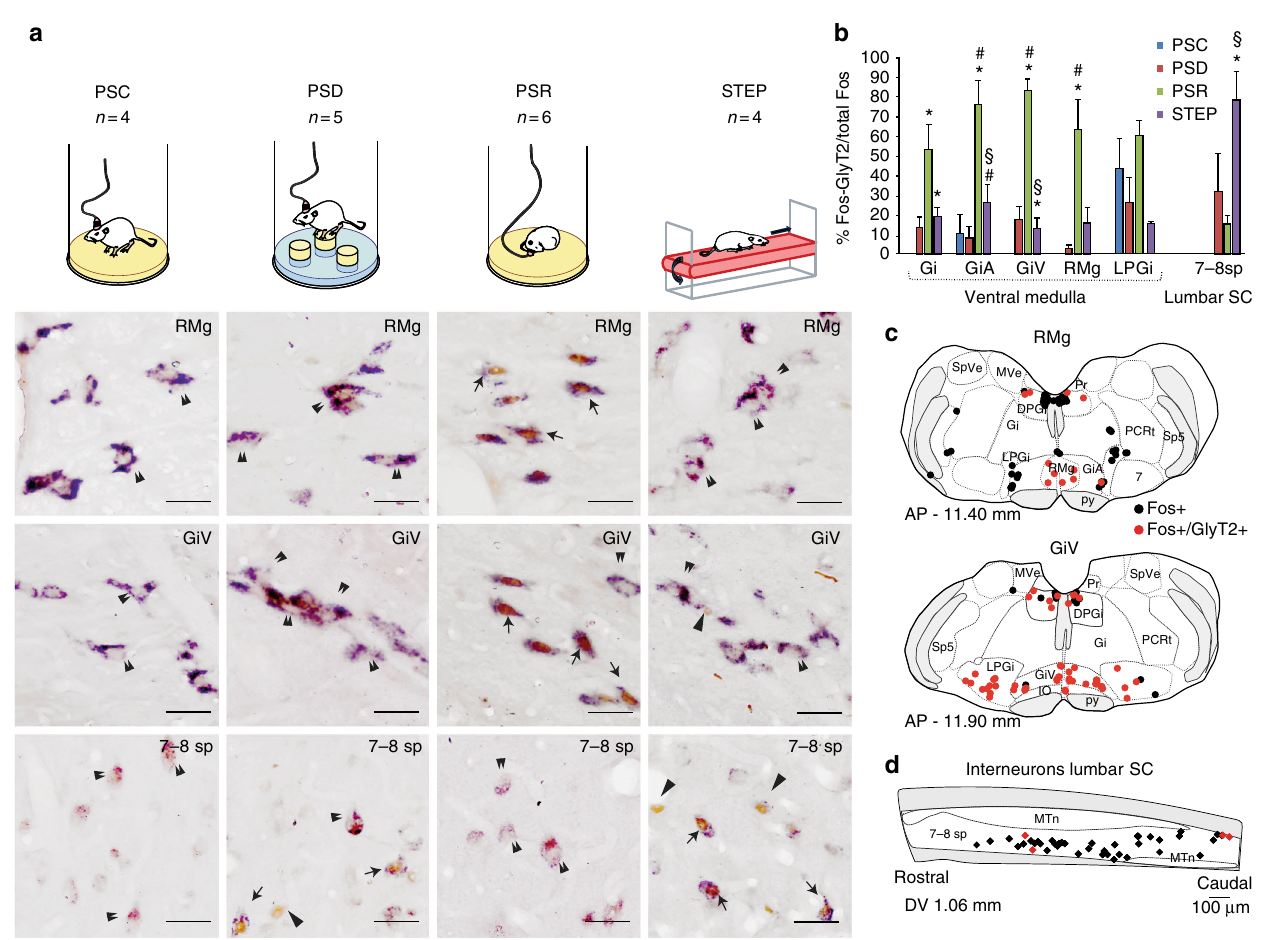
Fig. 1 GABA/glycine neurons of the ventromedial medulla (vmM) are speci fi cally active during PS rebound. a Photomicrographs comparing the distribution in RMg (upper row), GiV (middle row) and 7 – 8 sp Rexed ’ s layer of lumbar spinal cord (SC, lower row) of GlyT2+ neurons expressing c-Fos in control (PSC, fi rst column) and in rats submitted to a PS deprivation (PSD, second column), a PS rebound (PSR, third column) or a protocol of forced locomotion (STEP, fourth column). Neurons expressing c-Fos were colored in brown (nuclear staining, arrowheads) whereas GlyT2+ neurons were colored in blue (cytoplasmic staining, double arrowhead). Notice that the number of double-labeled neurons c-Fos+/GlyT2+ (arrows) in RMg (top line) and GiV (middle line) is higher during PSR compared to the 3 other experimental conditions. At spinal level, numerous c-Fos+/GlyT2+ neurons were found quite only in STEP rats. Scale bars: 50 µ m. b Histograms (mean ± SEM; n = 4 PSC, n = 5 PSD, n = 6 PSR, n = 4 STEP) illustrating the percentage of c-Fos+ that were